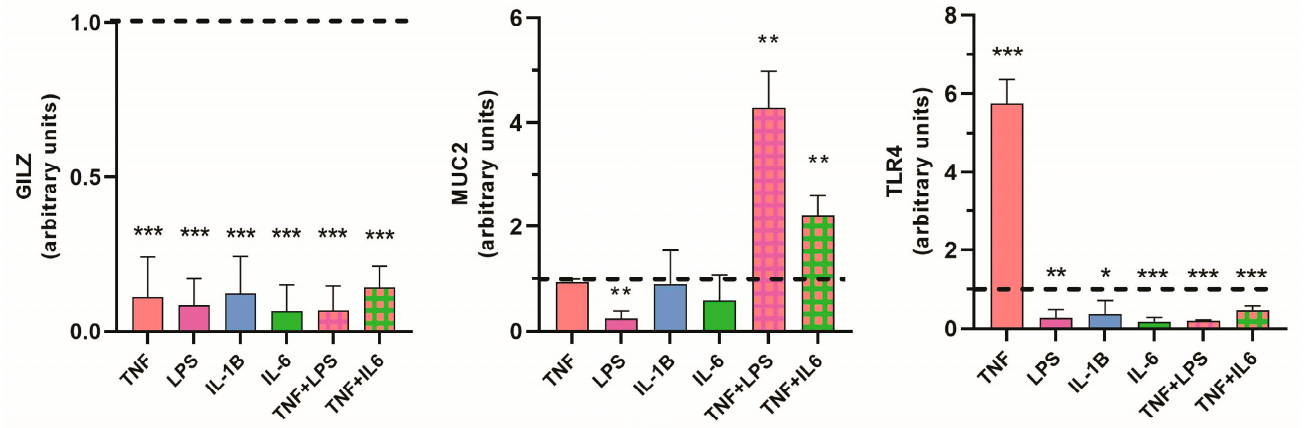
Figure 7. Quantitative PCR validation of bioinformatics data. HT29 cell extracts were used to measure GILZ , MUC2 , and TLR4 expression. Cells were treated with the indicated stimuli for 3 h. The expression of the genes was compared between treated and untreated (dotted line) control cells with the 2 − ∆ Ct method. Values are expressed as the mean ± SD for three different experiments; p < 0.05 = *; p < 0.01 = **; p < 0.001 = ***; p < 0.0001 =